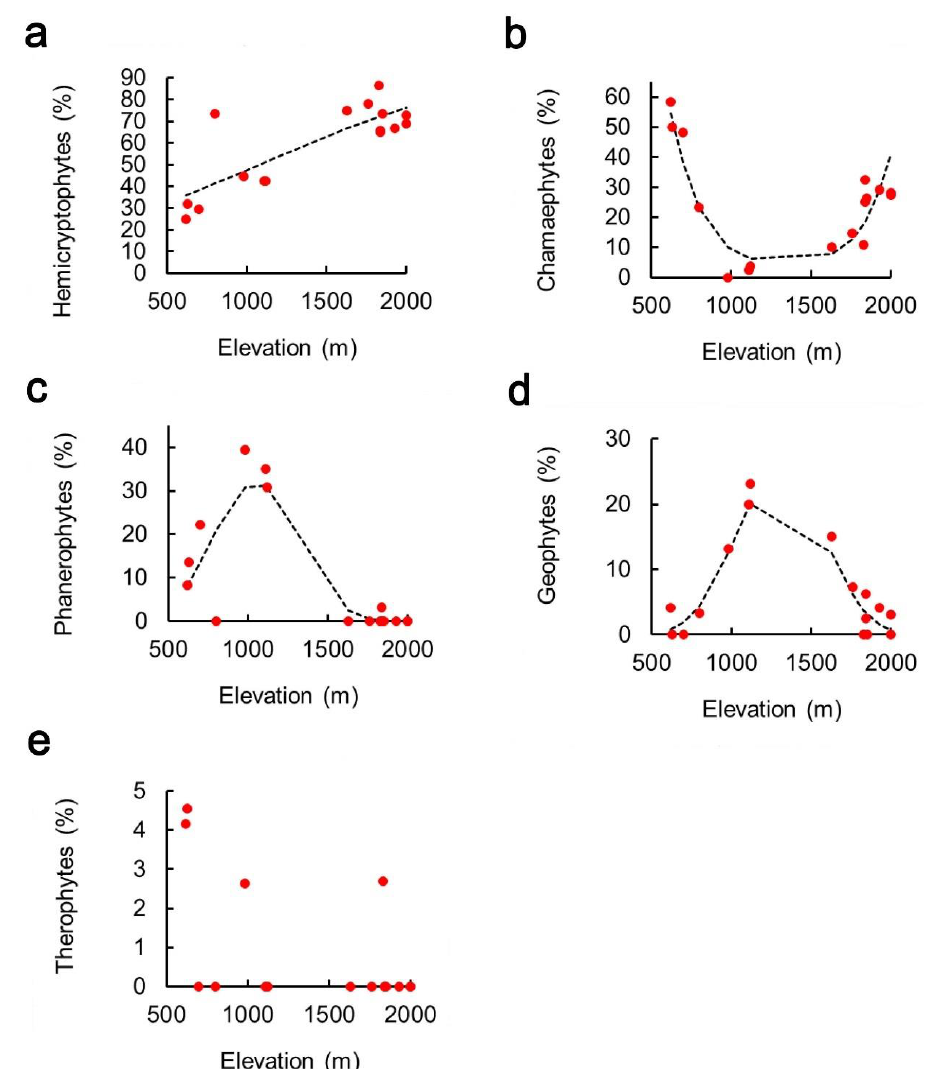
Figure 5. Relationship between percentage of life forms and elevation on a Central Apennine mountain (Mount Genzana): ( a ) Hemicryptophytes, ( b ) Chamaephytes, ( c ) Phanerophytes, ( d ) Geophytes, ( e ) Therophytes. Dashed lines are parabolic or monotonic fit obtained with generalized linear models. Fit parameters are reported in Table 2.